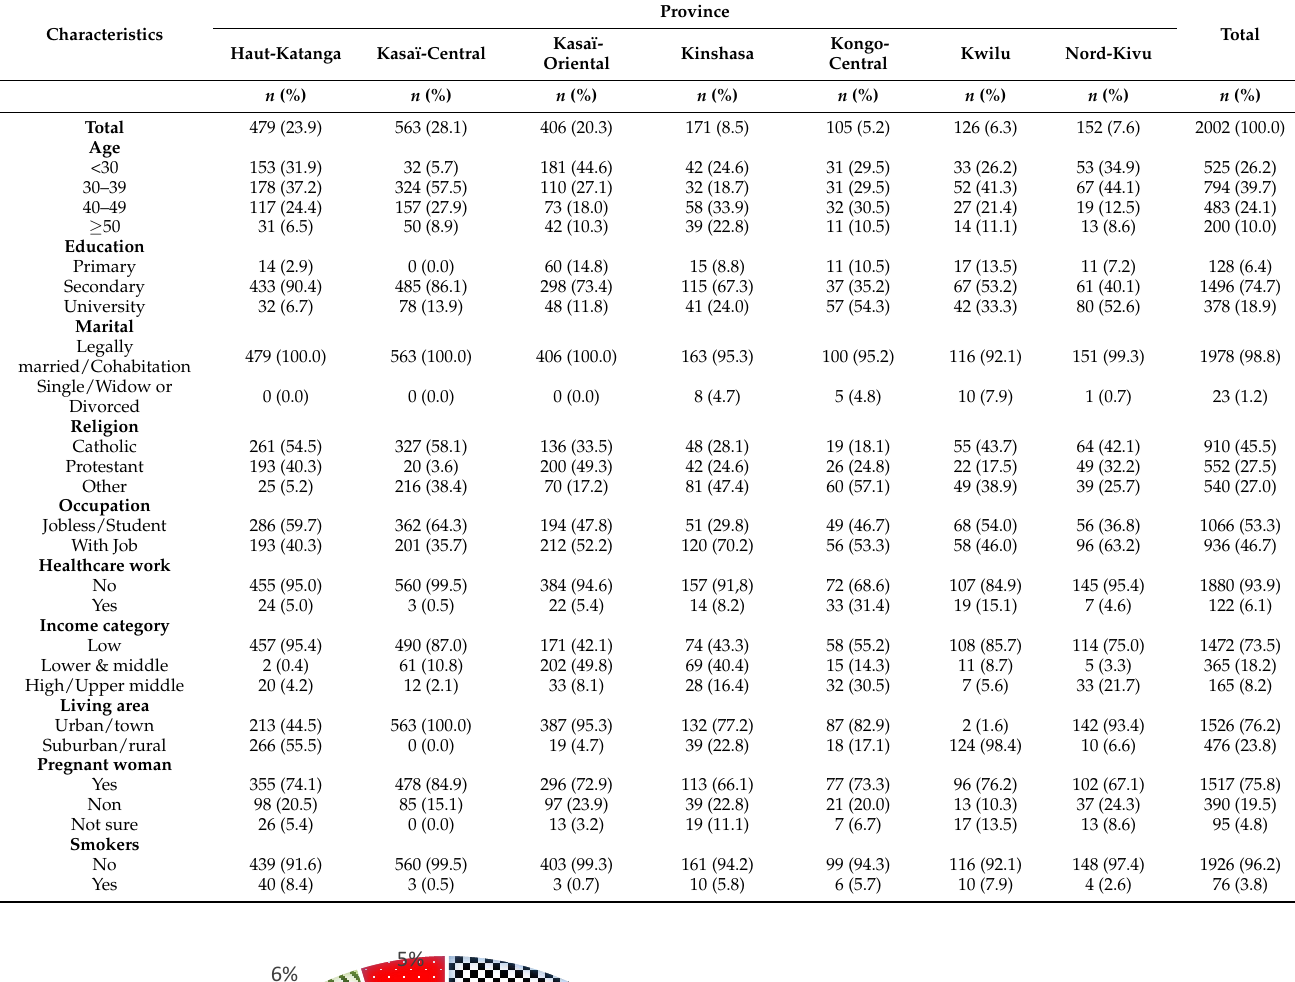
Table 2. Women’s sociodemographic characteristics ( n = 2002).